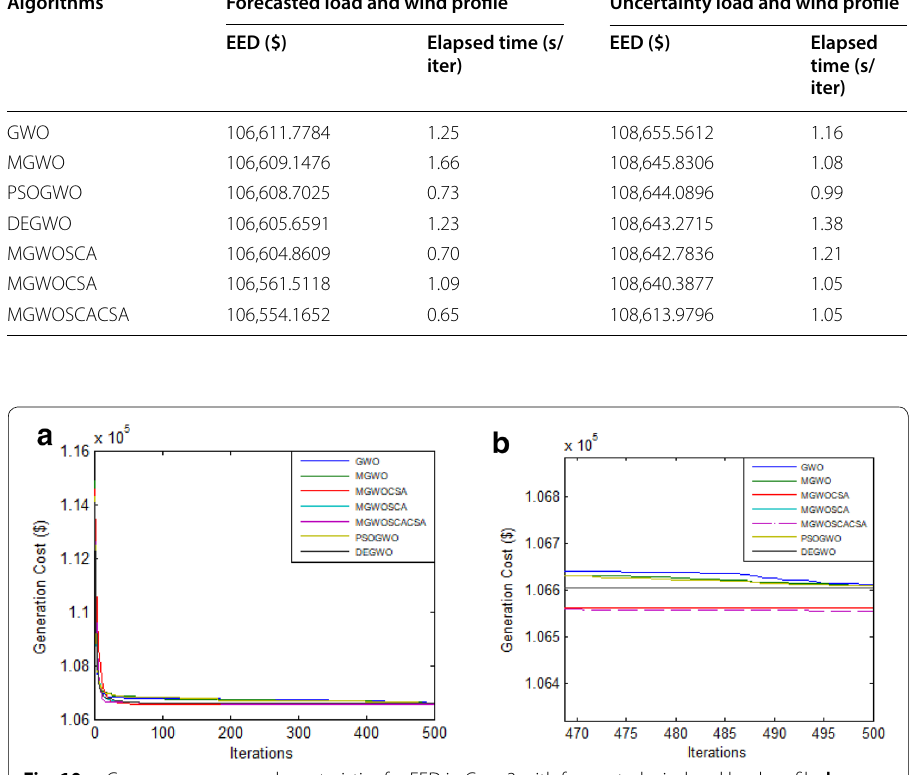
Table 4 Cost comparative analysis for EED during Case 3 using various algorithms Algorithms